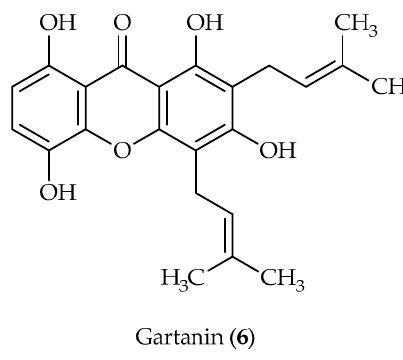
Figure 4. Chemical structure of Gartanin ( 6 ).